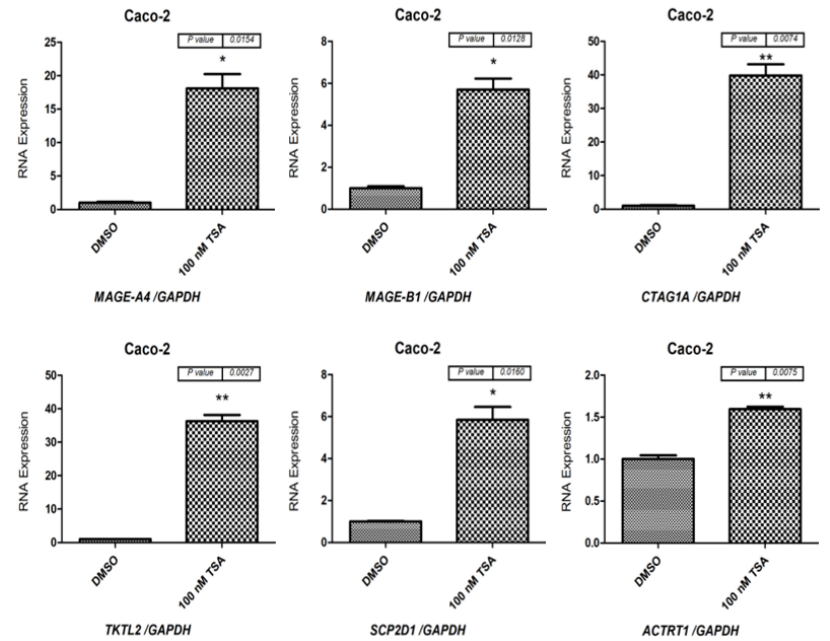
Figure 4. qRT-PCR analysis of MAGE-A4 , MAGE-B1 , CTAG1A , TKTL2 , SCP2D1 , and ACTRT1 expression in Caco-2 cells following treatment with 100 nM TSA for 48 h. The bar charts illustrate the expression of MAGE-A4 , MAGE-B1 , CTAG1A , SCP2D1 , TKTL2 , and ACTRT1 before and after TSA treatment in Caco-2 and HCT116 cells. The expression levels were normalized to GAPDH mRNA levels. The error bars represent the standard error of the mean for three replicates for each gene. * p ≤ 0.05, ** p ≤ 0.01.